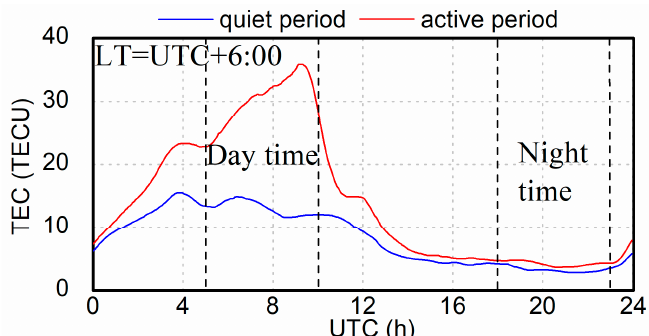
Figure 7. The vTEC values for station COCO on DOY 249 in 2017 (active period) and DOY 238 in 2017 (quiet period). The daytime (LT 12–17) and night ‐ time (LT 0–5) are separated by dashed lines.